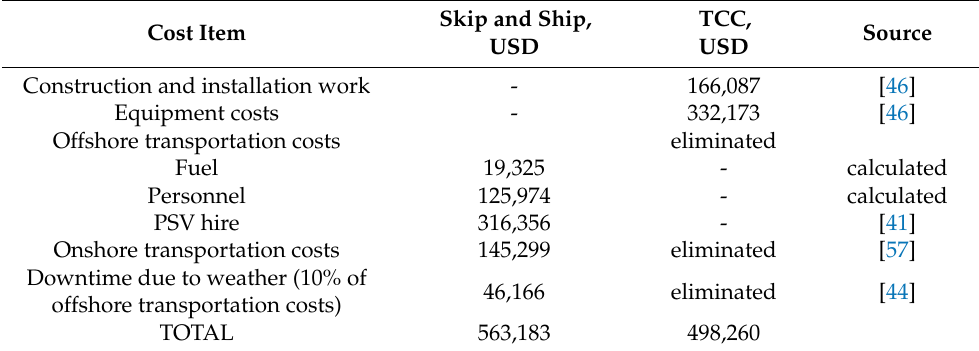
Table 6. Results of a comparison of drill cuttings disposal methods by cost items.